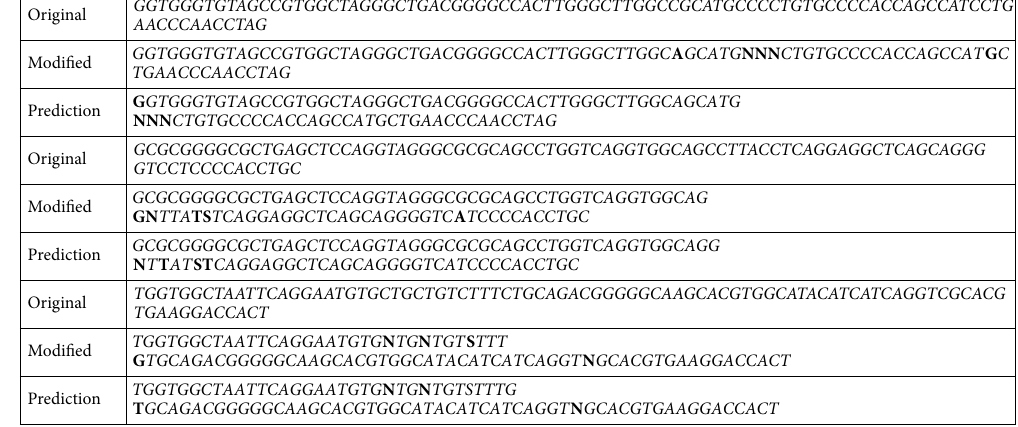
Table 9. Examples of the generative model modifying gene sequences and the discriminative model detecting the modifications (marked in